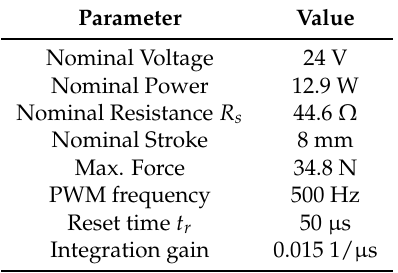
Table 1. Parameters of the used test solenoid as well as settings of the IDIM